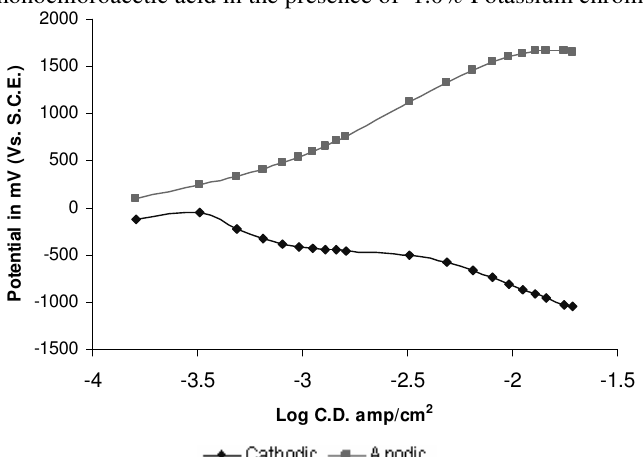
Figure 5 . Effect of varying current density on the cathode and anode potential of tin coated steel in 0.5M monochloroacetic acid in the presence of 1.5% Potassium